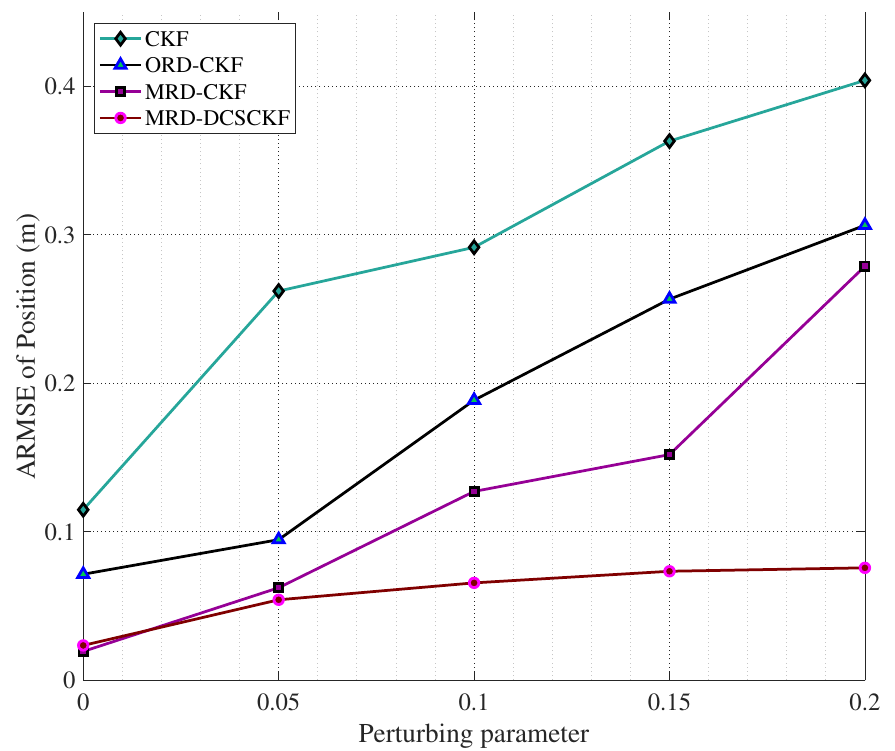
Figure 20. ARMSEs of position under different perturbing parameters.